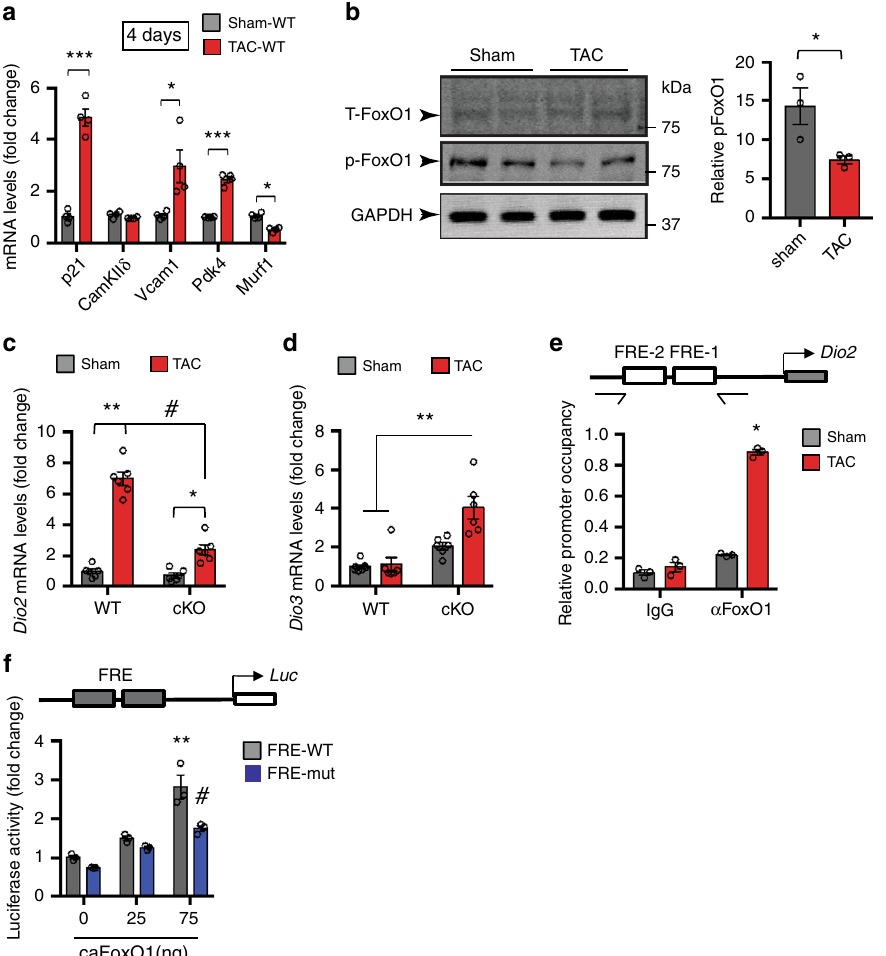
Fig. 3 Activation of FoxO1 in early post-TAC heart is required for reciprocal regulation of Dio2 and Dio3 genes expression. a qRT-PCR analyses of mRNA levels of indicated genes in 4 day TAC- and sham-operated LVs ( n = 4). b Immunoblotting (left) and quantitation (right) of total-FoxO1 (T-FoxO1) and phospho-FoxO1 (p-FoxO1) levels in 4 days TAC- and sham-operated LVs ( n = 3). GAPDH was used as a loading control. Average of p-FoxO1/T-FoxO1 and p-FoxO1/GAPDH ratios were used to determine relative p-FoxO1 levels. c , d qRT-PCR analyses of mRNA levels of Dio2 ( c ) and Dio3 ( d ) in 4 days TAC- and sham-operated LVs of FoxO1-WT (WT, n = 12) and FoxO1-cKO (cKO, n = 12) mice. e Quantitative ChIP assays were conducted in 4 day sham- and TAC-operated ventricles of the WT mice ( n = 3). Note the signi fi cant increase in FoxO1 occupancy at the Dio2 promoter in TAC hearts. Schematic of Dio2 illustrates that PCR ampli fi cation was performed using primers spanning the two FoxO-responsive elements (FREs) in the Dio2 promoter. f Schematic of Dio2 luciferase vector harboring two FREs. Note that co-transfection of a constitutively active FoxO1 (caFoxO1) elicited signi fi cant, concentration- dependent activation of reporter activity harboring WT, but not mutated, FREs. In all panels, data are depicted as mean ± SEM. * p < 0.05 vs sham/control; ** p < 0.01 vs sham; *** p < 0.0001 vs sham, # p < 0.05 vs WT ( f ); # p < 0.001 vs control ( c ). Statistical analyses were conducted using a two-tailed, unpaired Student ’ s t (Supplementary Fig. 5C) and a hypertrophic marker β MHC (Supplementary Fig. 5D) expression in TAC-stressed cardiomyo- cytes. Importantly, compared with Dio2 , Dio1 expression in isolated cardiomyocytes was essentially undetectable (Supple-